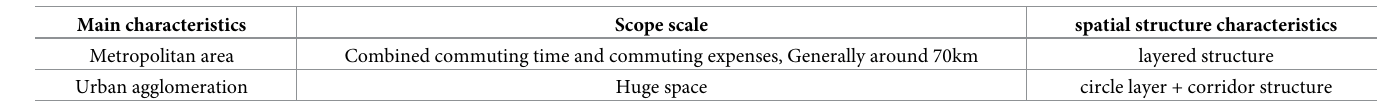
Table 2. Comparison of the scope and structural characteristics of metropolitan areas and urban